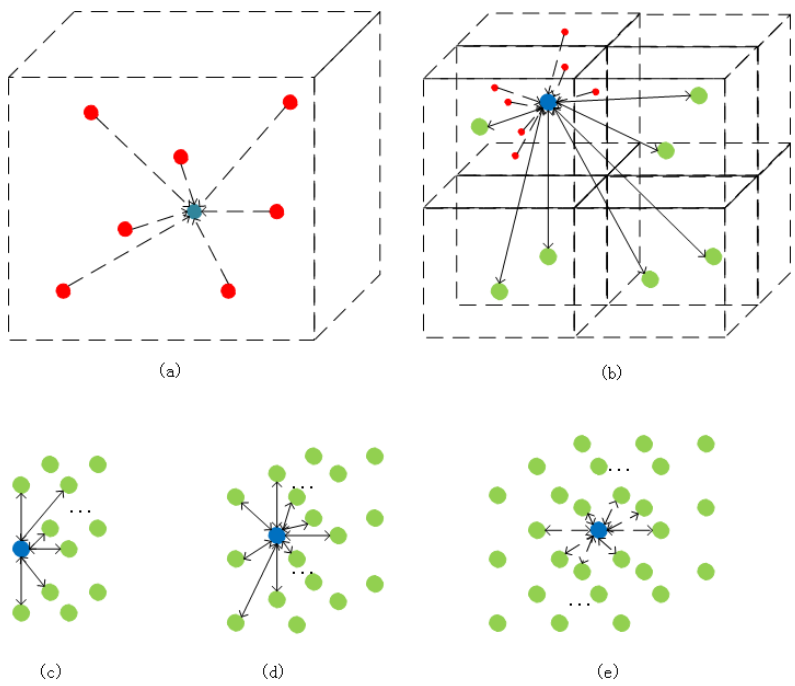
Figure 4. The mapped points rule of the proposed method for the neighborhood of each central point. ( a ) describes the appearance of point clouds in a divided 3D space. ( b , e ) describe the area that affects a single divided 3D space in the entire point cloud space. ( c ) is the position described on the edge of the entire space. ( d ) is the position described on the surface of the entire space. ( e ) is the position described on the internal area of the entire space.